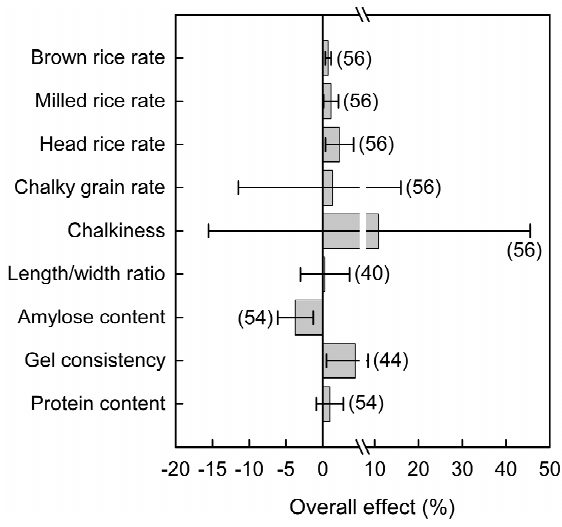
Figure 4. Effects of potted-seedling machine transplantation on brown rice rate, milled rice rate, head rice rate, chalky grain rate, chalkiness, length/width ratio, amylose content, gel consistency, and protein content in paddies. The numbers near the error bars denote the number of observations for each variable. Error bars represent 95% confidence intervals.